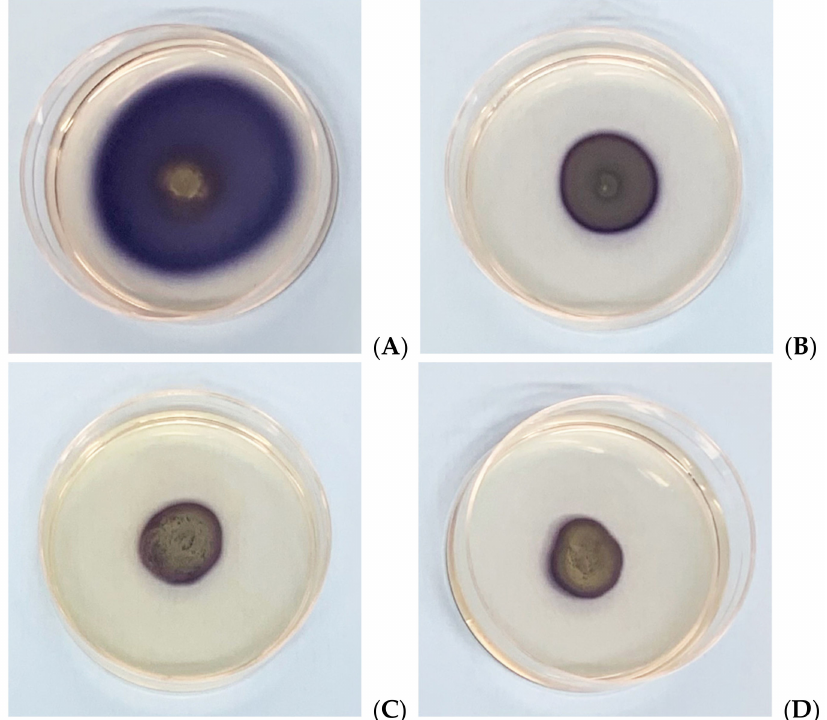
Figure 3. Effects of MOEs on swarming motility; images represent soft-agar plates inoculated with Xcc; the colored area is formed by formazan metabolized by the swarmed bacteria; ( A ) control, ( B ) HAMOE 1 mg/mL; ( C ) MeOH-MOE 1 mg/mL; ( D ) HAMD-MOE 1